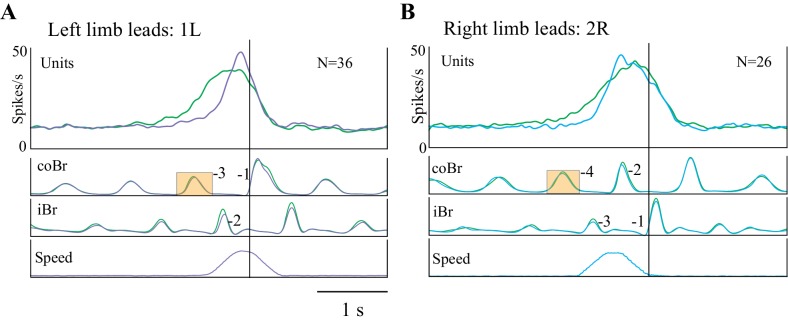
Population activity during obstacle acceleration.(A,B) Population discharge activity is shown for all cells for which we applied the 1L and 2R protocols. Green traces show averaged activity in the visual dissociation task; the purple trace indicates the 1L acceleration condition; and the cyan trace indicates 2R condition. Data aligned to the onset of activity in the Br during the step over the obstacle. Boxes on the coBr trace in A,B indicate the burst used to trigger the acceleration (Figure 9—figure supplement 1: Population averages during Acceleration Task).